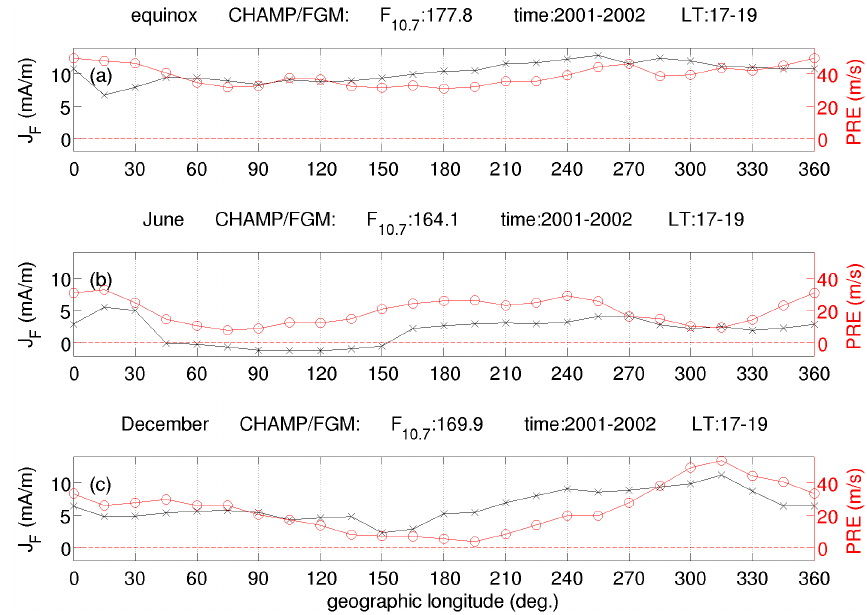
Fig. 2. Seasonal-longitudinal distribution of the F-region dynamo current density (black crosses) and PRE peak velocity (red circles). Each panel corresponds to a different season. Positive (negative) current density denotes upward (downward) current at the dip equator.